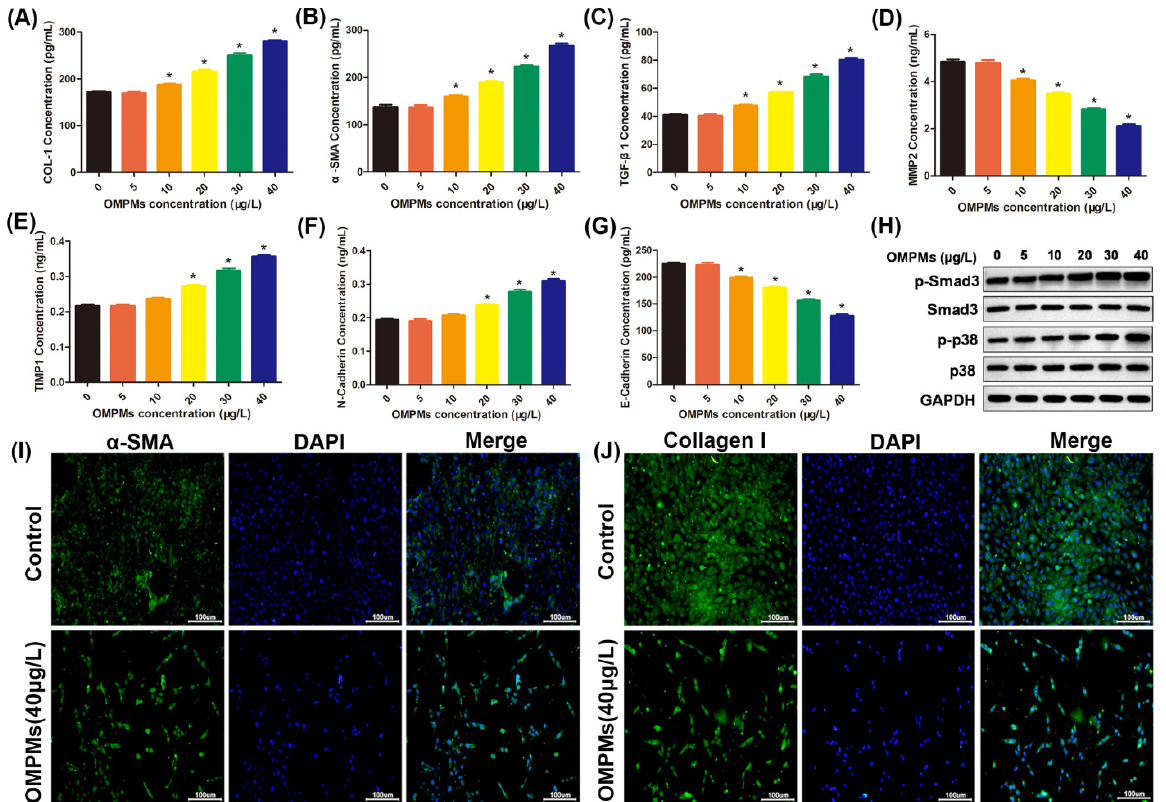
Figure 4. OMPM exposure induced fibrotic phenotypes in the BEAS-2B cell line. ( A ) COL-1 con- centration; ( B ) α -SMA concentration; ( C ) TGF- β 1 concentration; ( D ) MMP2 concentration; ( E ) TIMP1 concentration; ( F ) N-cadherin concentration; ( G ) E-cadherin concentration. ( H ) Phosphorylation of Smad3 and p38 after OMPM exposure detected with Western blotting. ( I ) α -SMA expression after OMPM exposure was detected using immunofluorescence. ( J ) Collagen I expression after OMPM exposure was detected using immunofluorescence; 100 × , bar: 100 µ m. Data represent mean ± SD. * p < 0.05 vs. the control group.